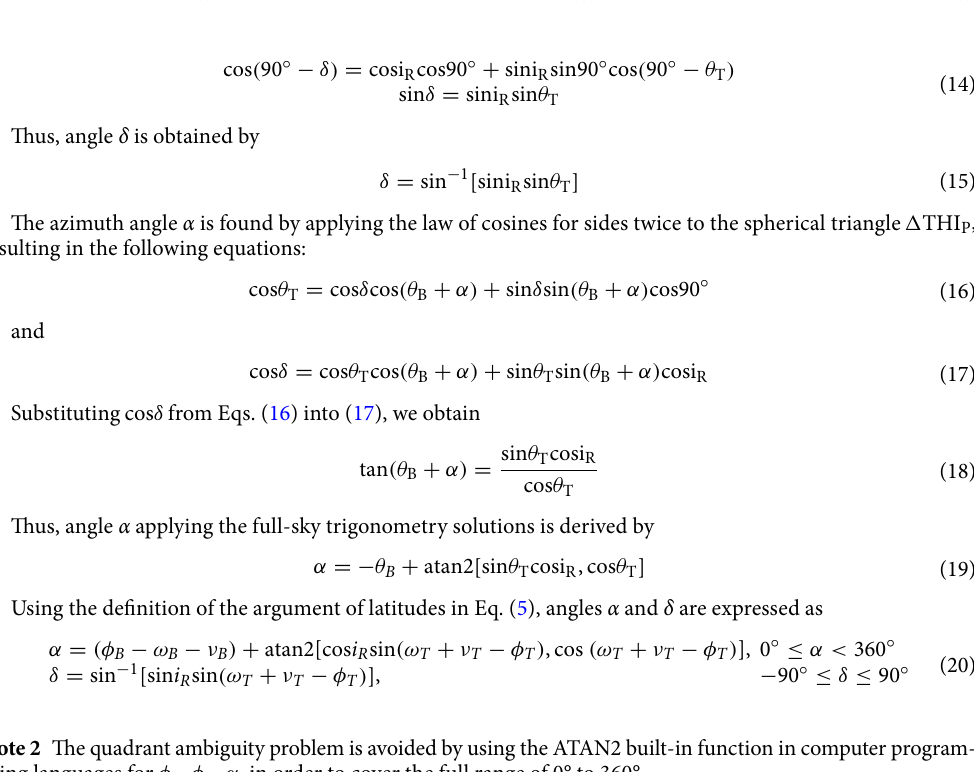
Figure 5. Geometry for computing α and δ with ∆Ω =